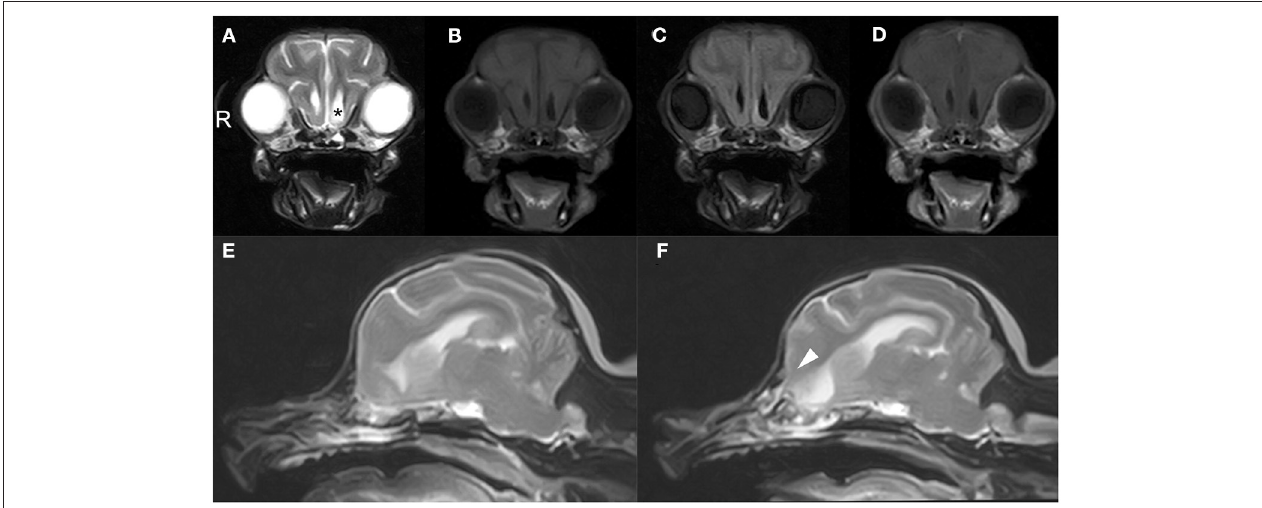
FIGURE 1 | Brain magnetic resonance images of a 12-year-old Yorkshire terrier with epileptic seizures and nasal discharge (A–F) . Transverse T2 weighted (A) , T1 weighted (B) , FLAIR (C) , and T1 weighted post-contrast (D) images at the level of olfactory recess, and sagittal T2W1 image at the level of the right and left cribriform plate ( E, F , respectively). Olfactory recess of the left lateral ventricular enlargement was observed (black asterisk) relative to the right lateral ventricle (A) . A defect of the left cribriform plate was observed (white arrowheads, F ) relative to right cribriform plate (E)